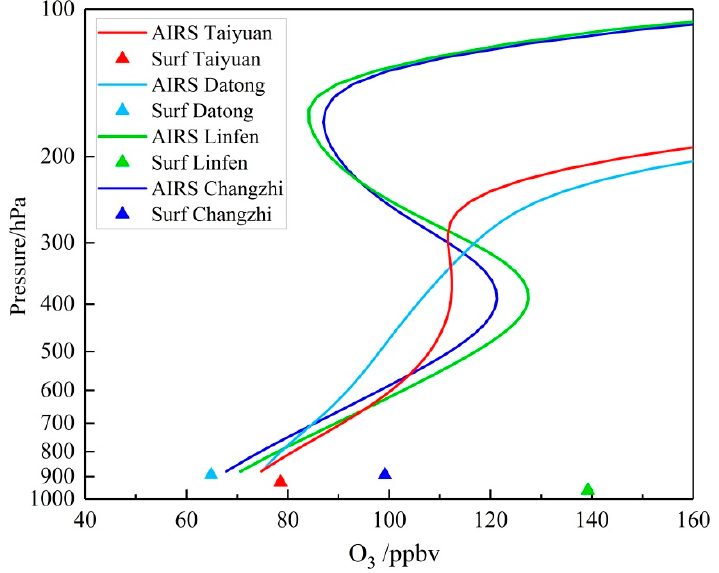
Figure 16. O 3 VMR vertical profiles from AIRS at 13:00 BJT (Beijing time) on June 1, 2017. The triangle points present the surface O 3 values from ground monitoring stations, and the solid lines show O 3 VMR in the four typical cities.